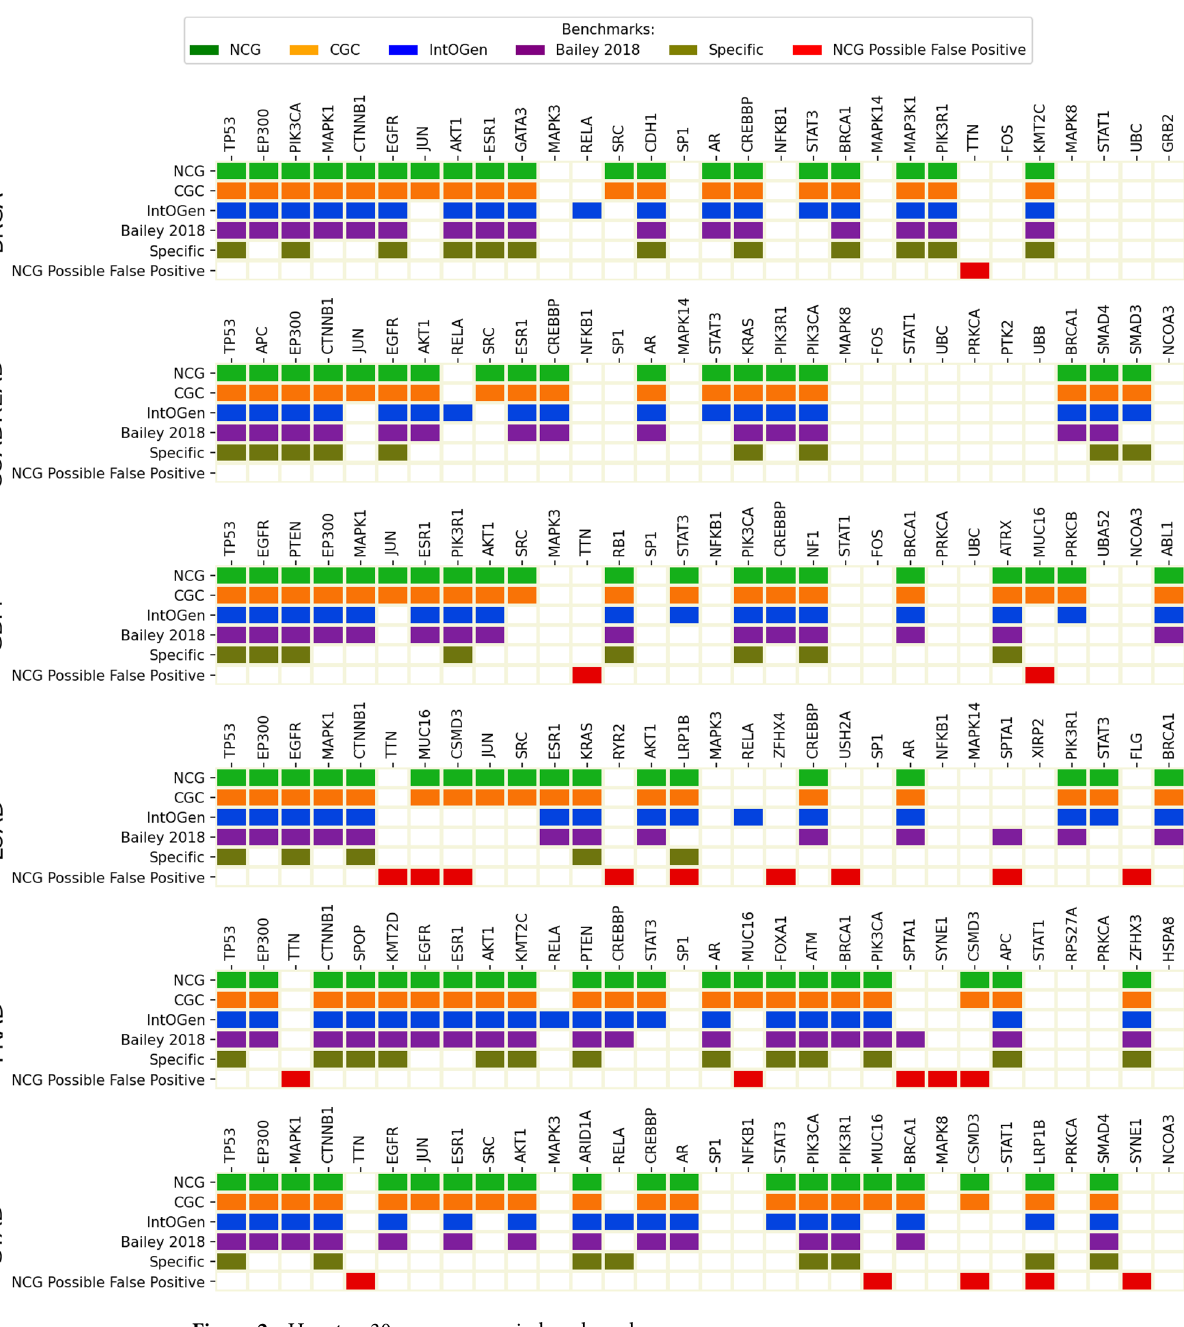
Figure 2. How top 30 genes appear in